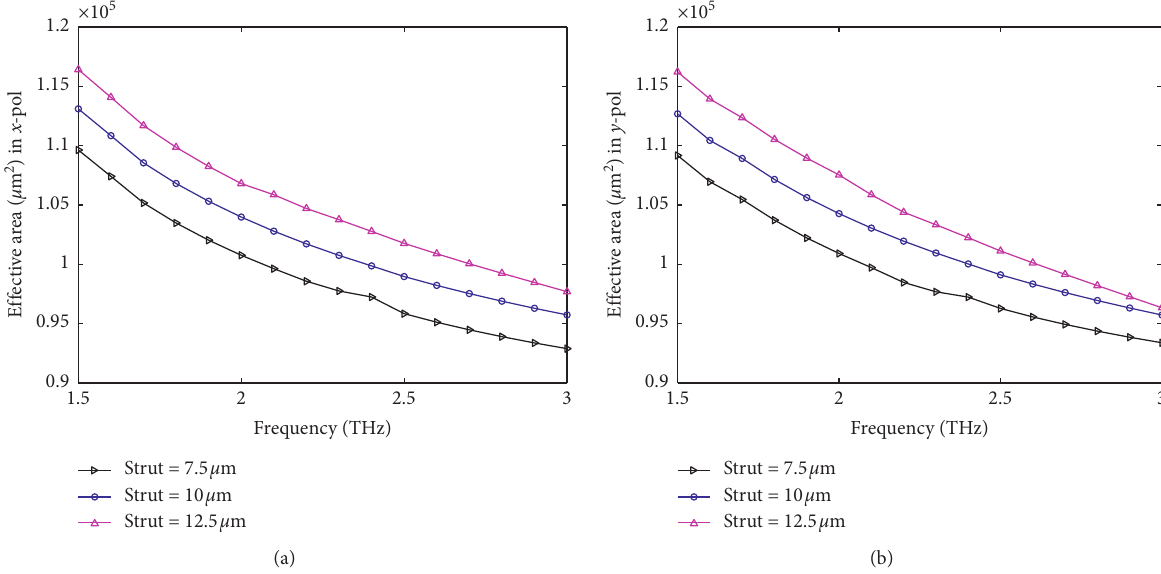
Figure 9: Representation of the EAs for the three models with different strut values in the THz band. (a) x -PoM and (b) y -PoM.